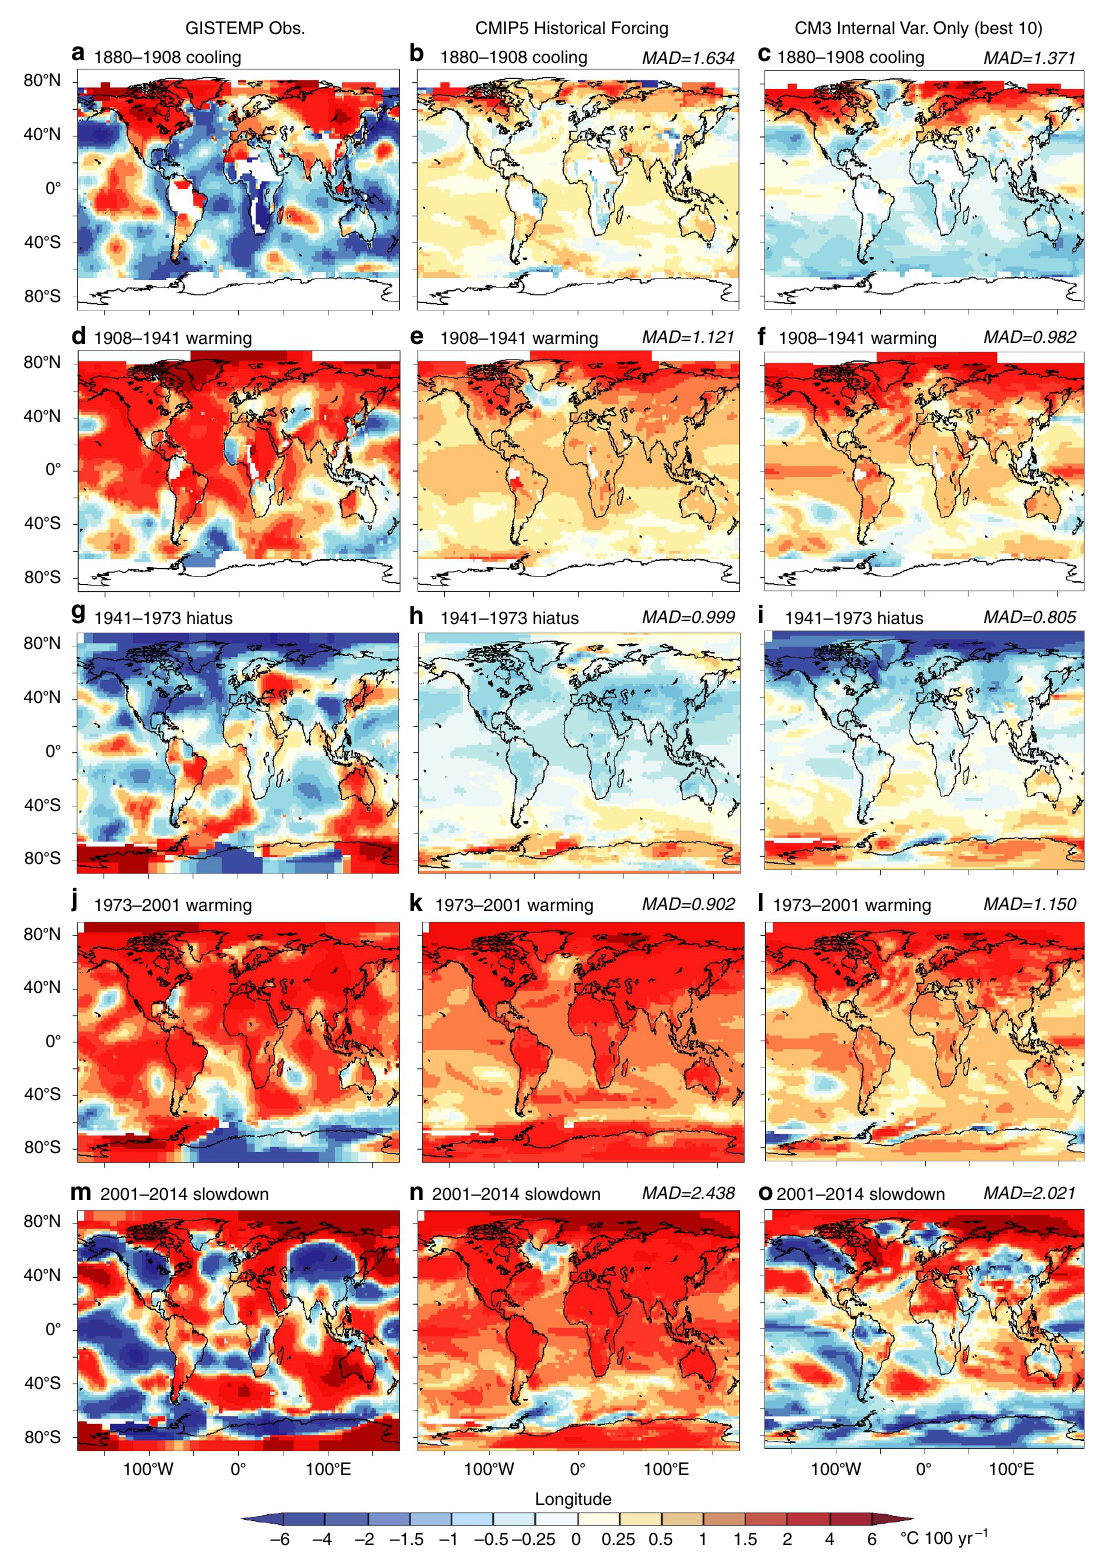
Figure 7 | Maps comparing historical observed and CMIP5-simulated trends with trends based on CM3 internal variability only. Panels ( a , b , d , e , g , h , j , k , m and n ) are repeated from Fig. 6, while panels ( c , f , i , l and o ) are based on CM3 model-simulated internal variability only. Unit: (cid:2) C 100 yr (cid:2) 1